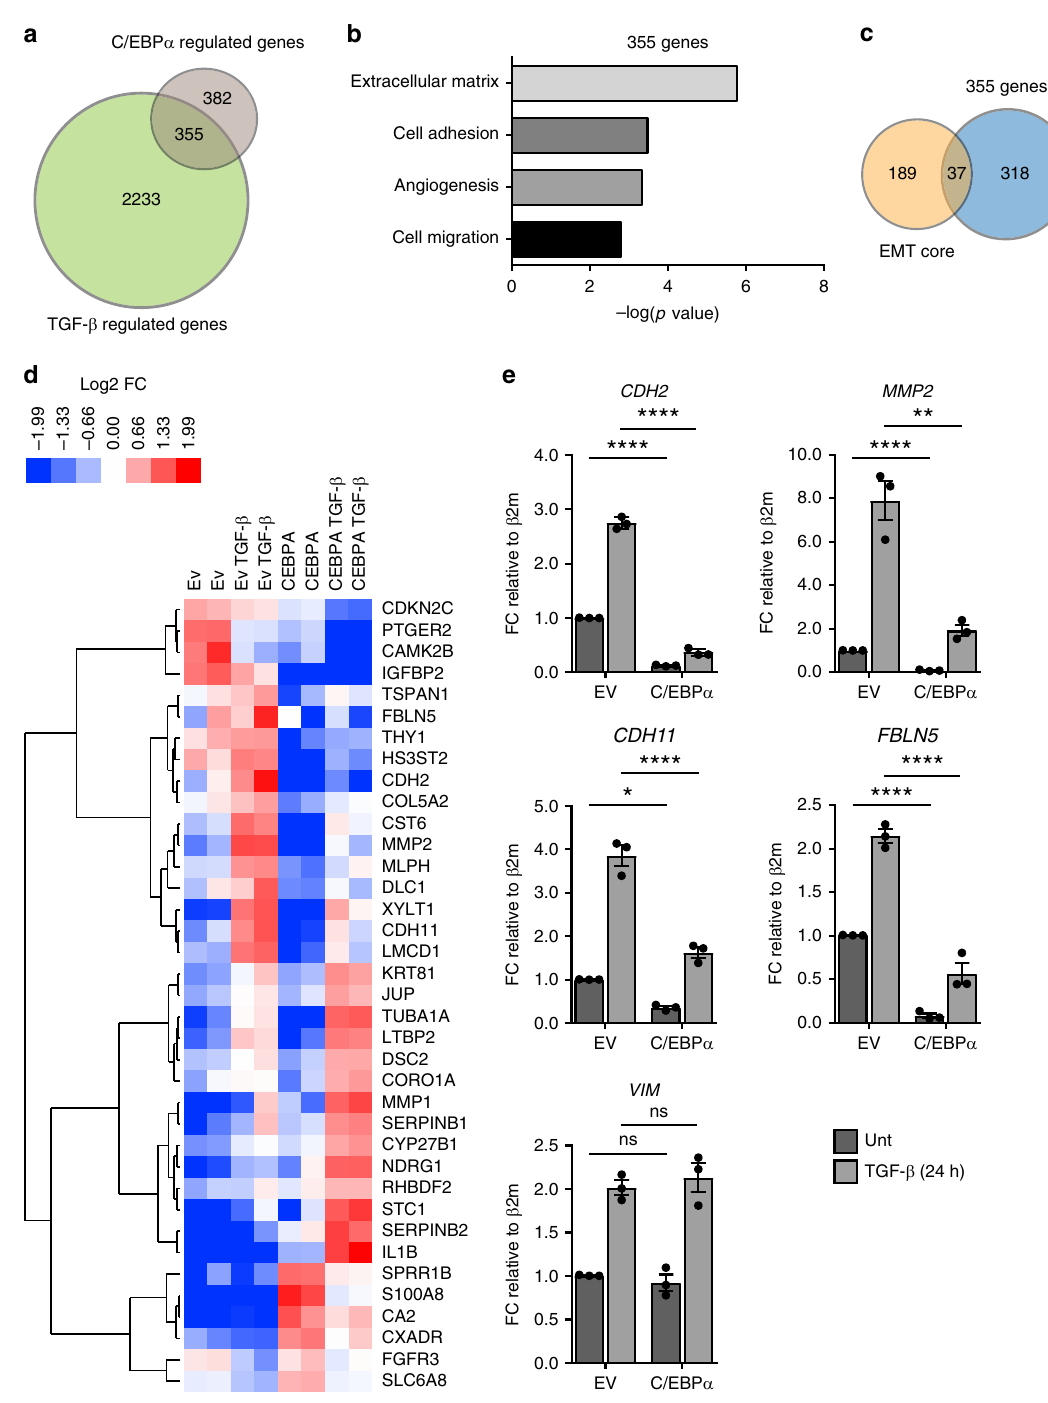
Fig. 3 C/EBPa is important for TGF- β -induced EMT. a HMLE cells expressing empty vector (EV) or constitutive CEBPA were either left untreated or treated with 2.5 ng/ml of TGF- β for 24 h. RNA samples were isolated, and puri fi ed RNA was sequenced as described in “ Methods ” . Venn diagram showing the overlap of genes regulated by TGF- β with genes regulated by constitutive expression of C/EBP α . b Gene-ontology (GO) analysis on the 355 TGF- β - and C/EBP α -regulated genes. c Venn diagram showing the overlap of 355 TGF- β - and C/EBP α -regulated genes with public available EMT core genes. d Heatmap displaying gene expression of the 37 genes overlapped between EMT core and TGF- β -C/EBP α core. e qRT-PCR analysis validating RNA- sequencing data. HMLE cells expressing empty vector (EV) or constitutive CEBPA were left untreated or treated with 2.5 ng/ml of TGF- β for 24 h. Vimentin ( VIM ) was taken along as negative control. Data represented as mean ± SD of three independent experiments. p -values were calculated using unpaired two-tailed Student ’ s t test. * p < 0.05, ** p < 0.01, *** p < 0.001, **** p < 0.0001. ns not signi fi cant, FC, fold change, β 2m